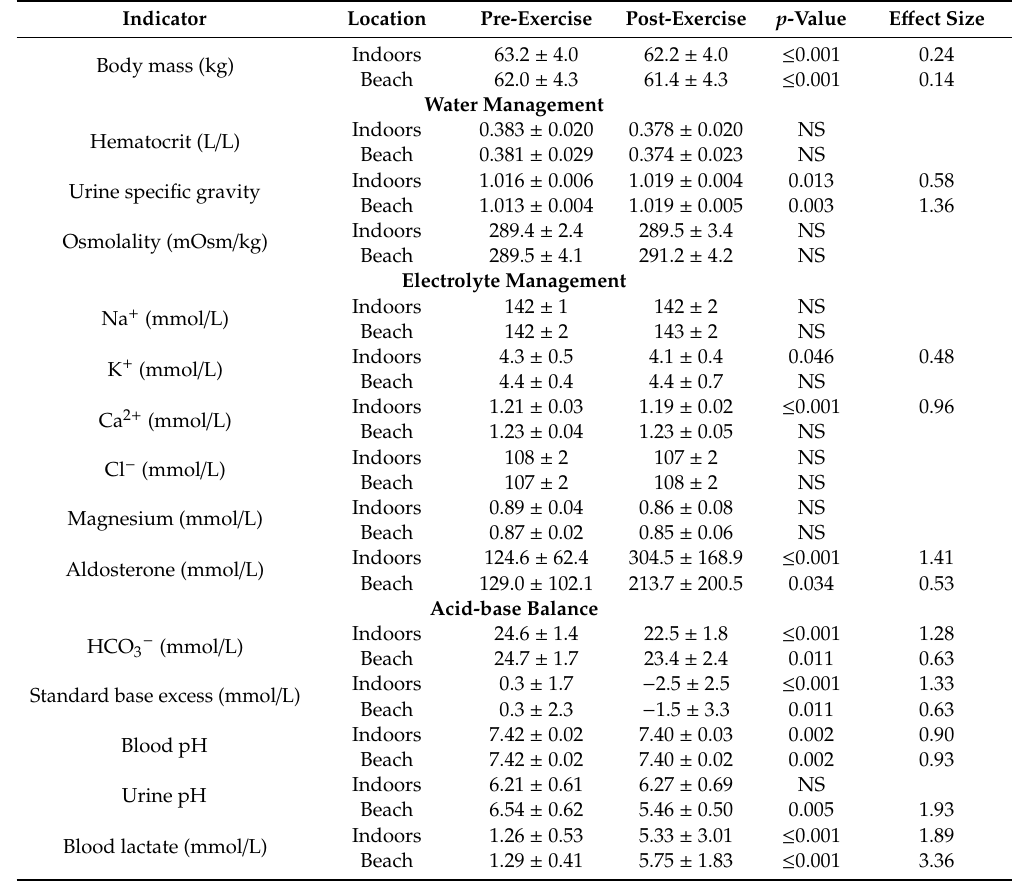
Table 2. Average values of the analysed indicators measured before and after both types of simulated matches.